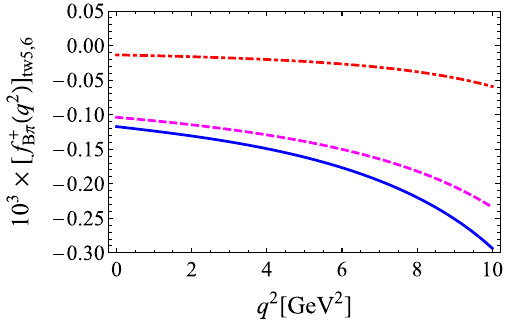
Fig. 2 The factorizable twist-5 and twist-6 corrections to the vector B → π form factor. The dot-dashed ( red ) curve is the twist 6. The dashed ( magenta ) one is the twist 5 and the solid ( blue ) curve is the sum of the two